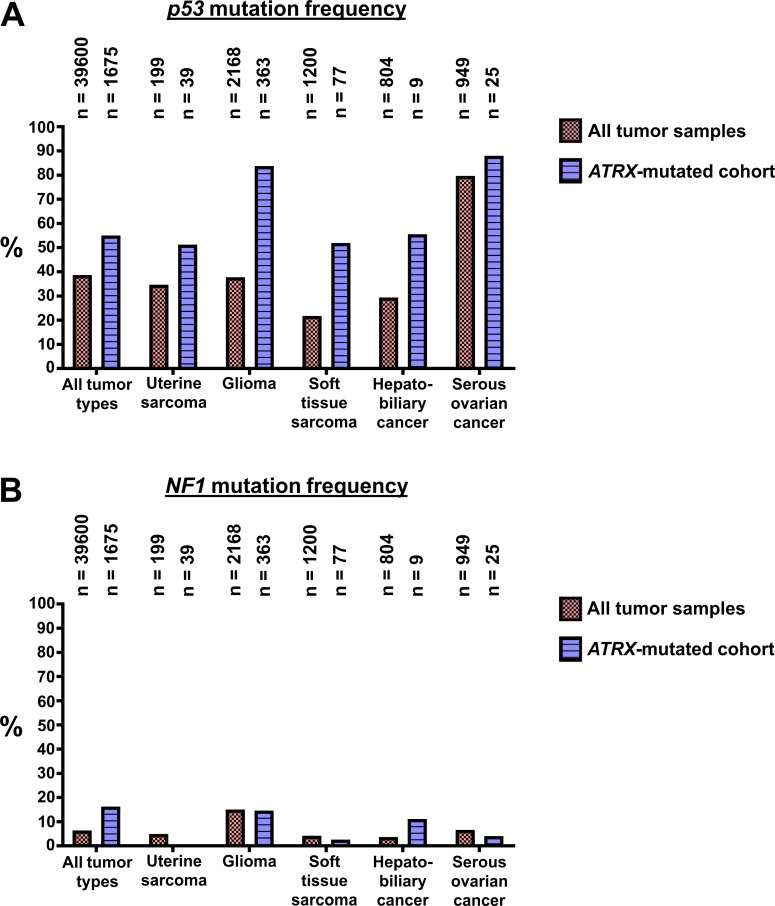
AACR Genie data on the co-occurrence of mutations in ATRX and p53 or NF1 in selected tumor types.Data on mutation frequencies in p53 and NF1 were extracted from the AACR Genie Database [32].